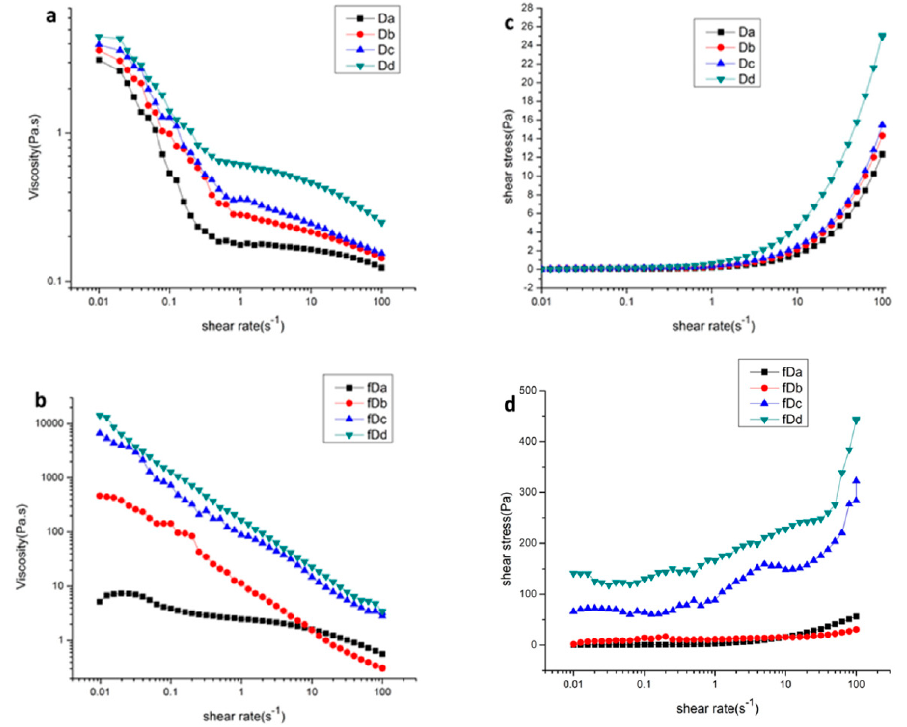
Figure 5. The steady state flow curves of KGM sols with di ff erent deacetylation degree before and after freezing dealt. Table 2. Parameters of KGM sols with di ff erent amount of alkali dealt before and after freezing treatment estimated by Power law